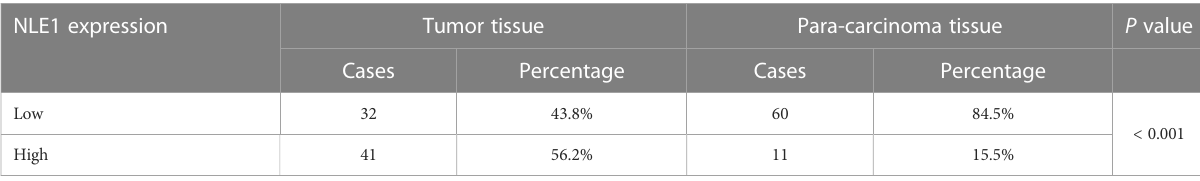
TABLE 1 Expression patterns of NLE1 in non-small cell lung cancer tissues and para-carcinoma tissues revealed in immunohistochemistry analysis.